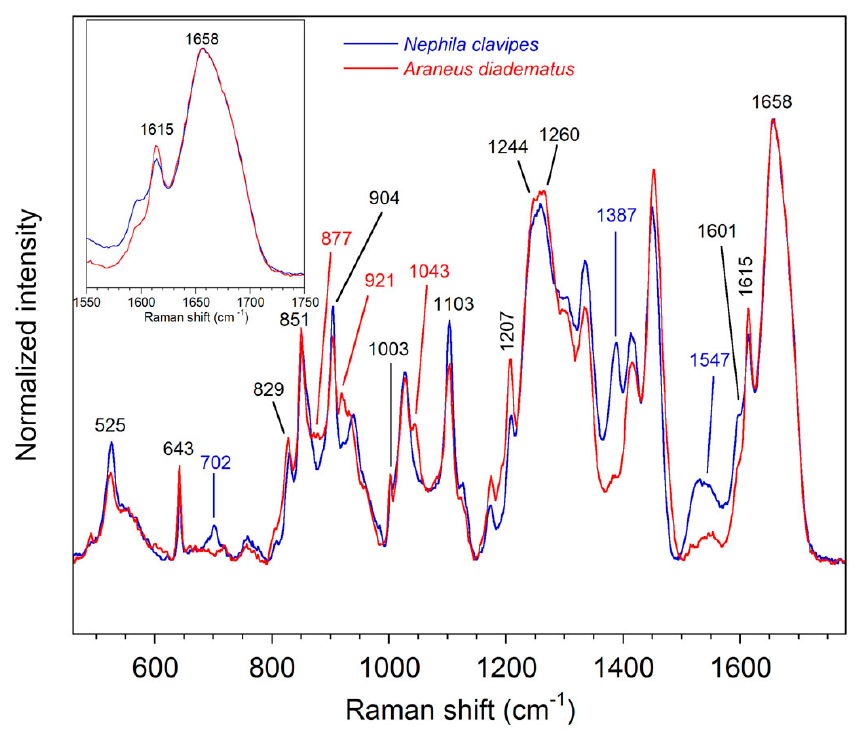
Figure 2. Raman spectra of the spinning dope contained in the sac of the Nephila clavipes ( NC ) and Araneus diadematus ( AD ) MA glands.